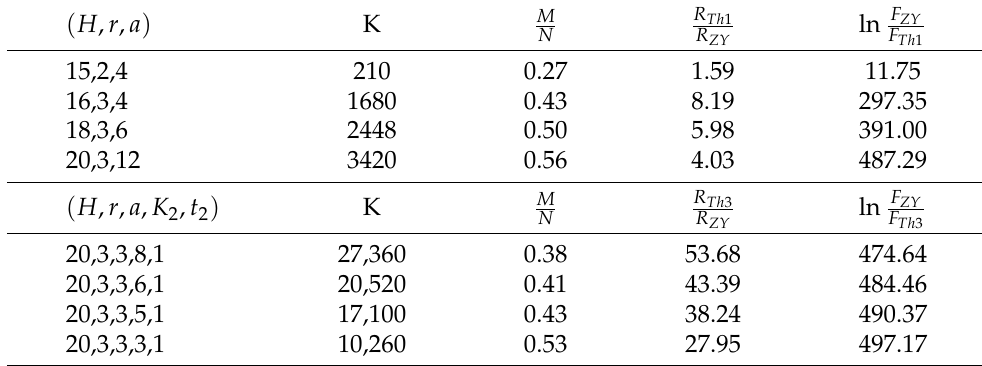
Table 3. Numerical comparison of the direct scheme and the hybrid scheme when ω = 1, λ = 1 with the ZY